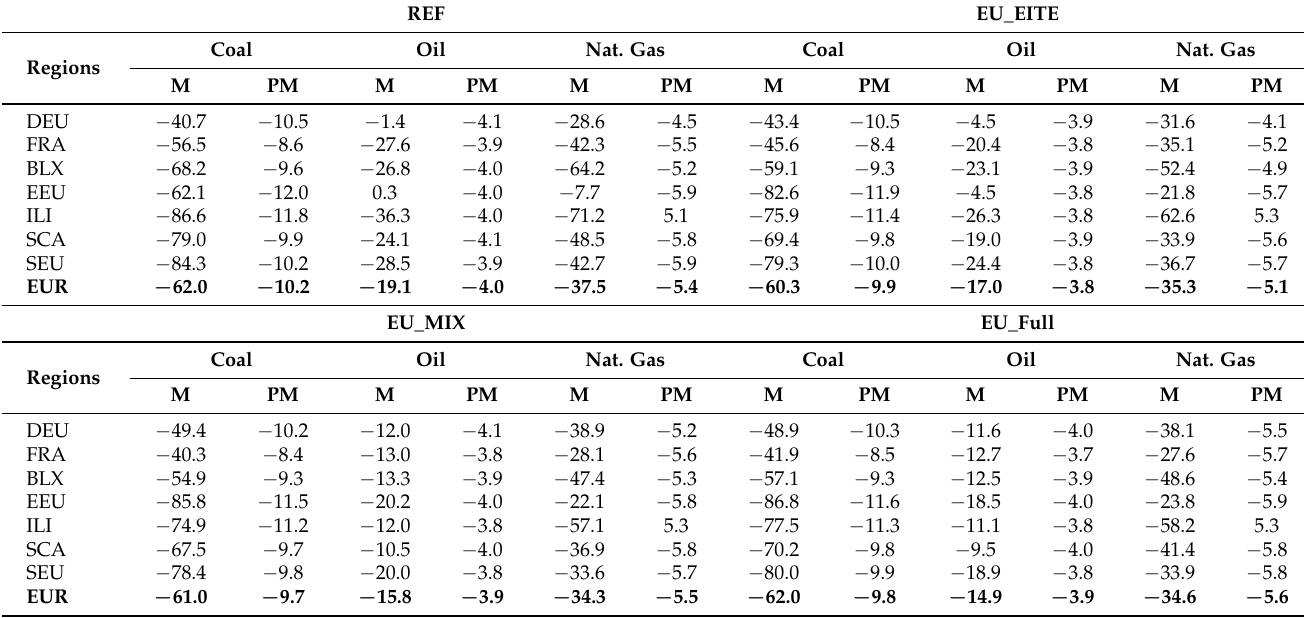
Table 9. Import quantity (M) and import price (PM) of different fuels for different policy scenarios under the NDC target using the IEO